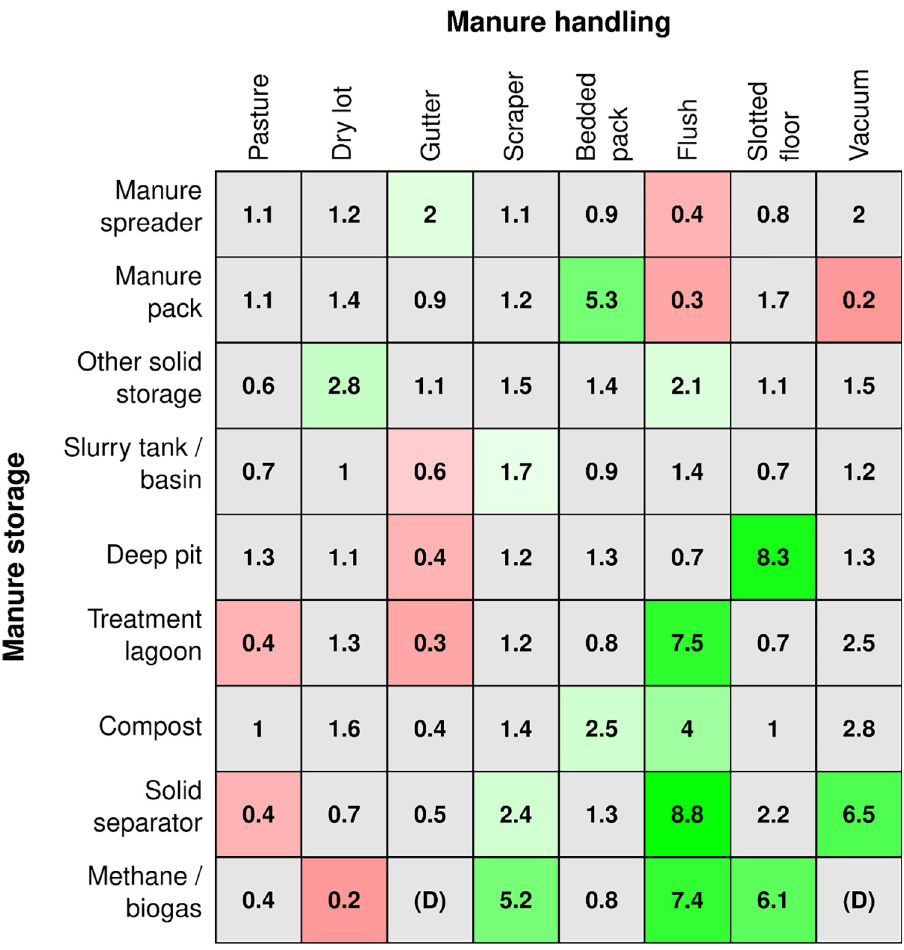
Fig 6. Relationship of manure handling to manure storage. Results of nine logit models taking handling methods as the independent variables, and each storage method as the dependent variable. Odds ratios (OR) from each of the logit models are given, with red shading indicating an estimated OR < 1, and green an OR > 1. Models in which the association did not achieve significance at the family-wise p < 0.05 level across rows are color-coded